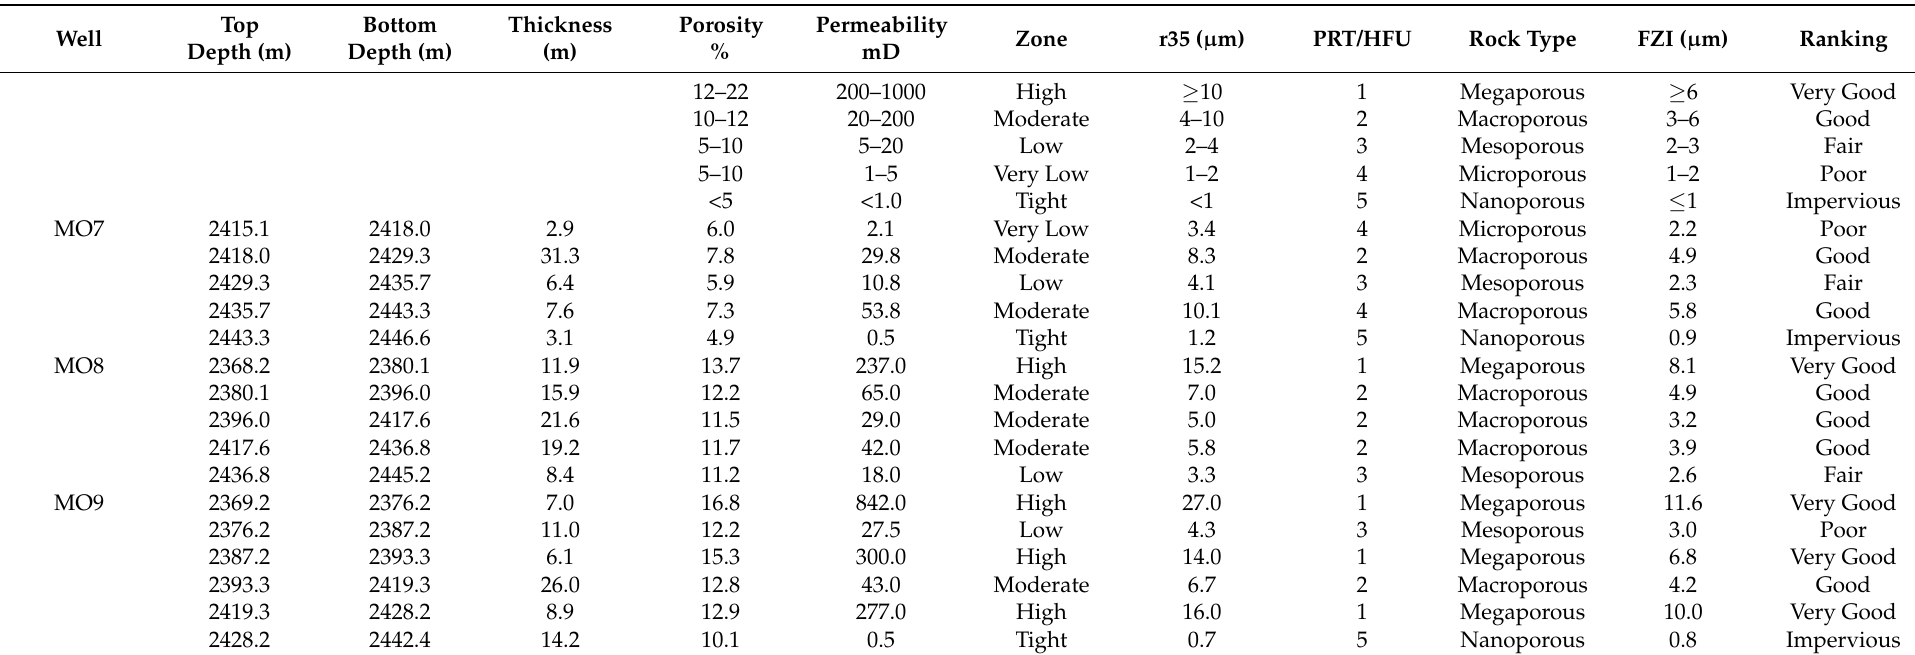
Table 1. Results of calculated petrophysical rock types and flow zone indicators used to classify rocks into different flow zones.